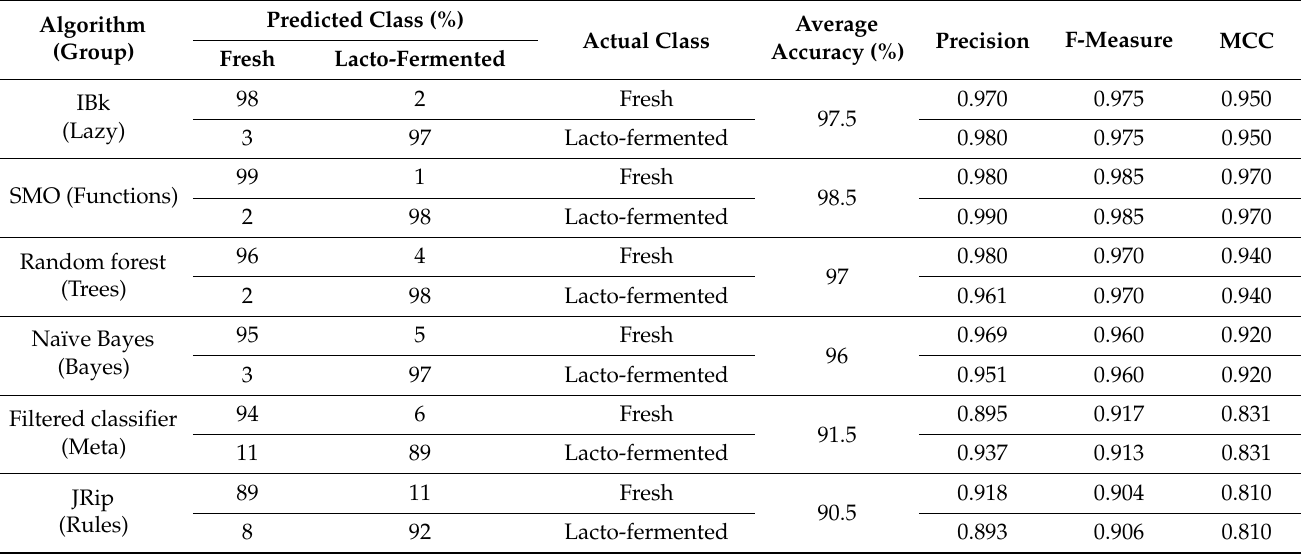
Table 5. The performance metrics of distinguishing fresh and lacto-fermented red bell pepper samples using selected image textures from color channel R .